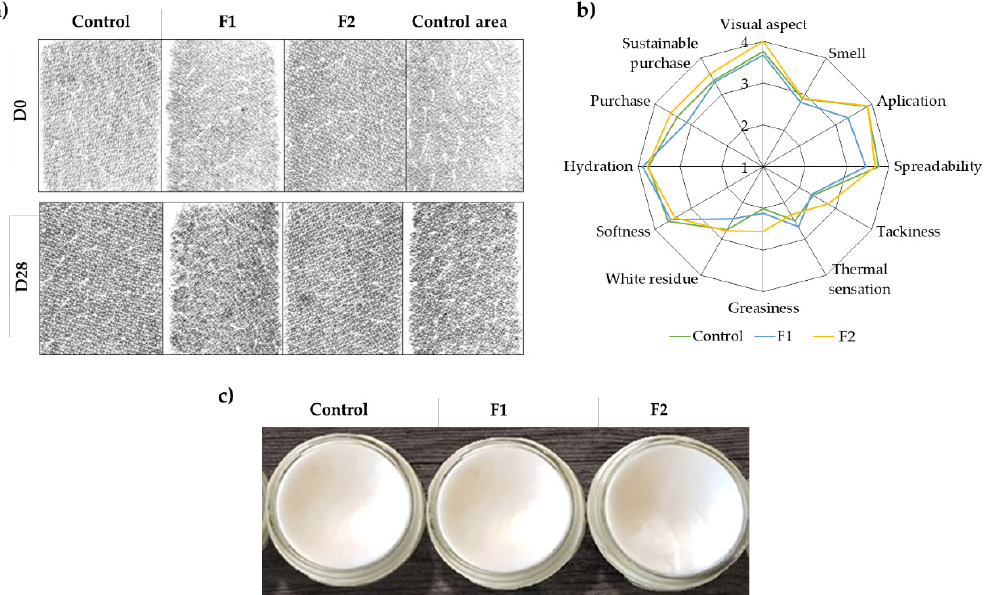
Figure 4. ( a ) Hydration images of the skin on the volar side of the forearm of one of the volunteers extracted from the MoistureMap MM 100 device before and after application. ( b ) Sensory profiles. In vivo assays ( n = 9). ( c ) Macroscopic aspect of the validated formulations and control.